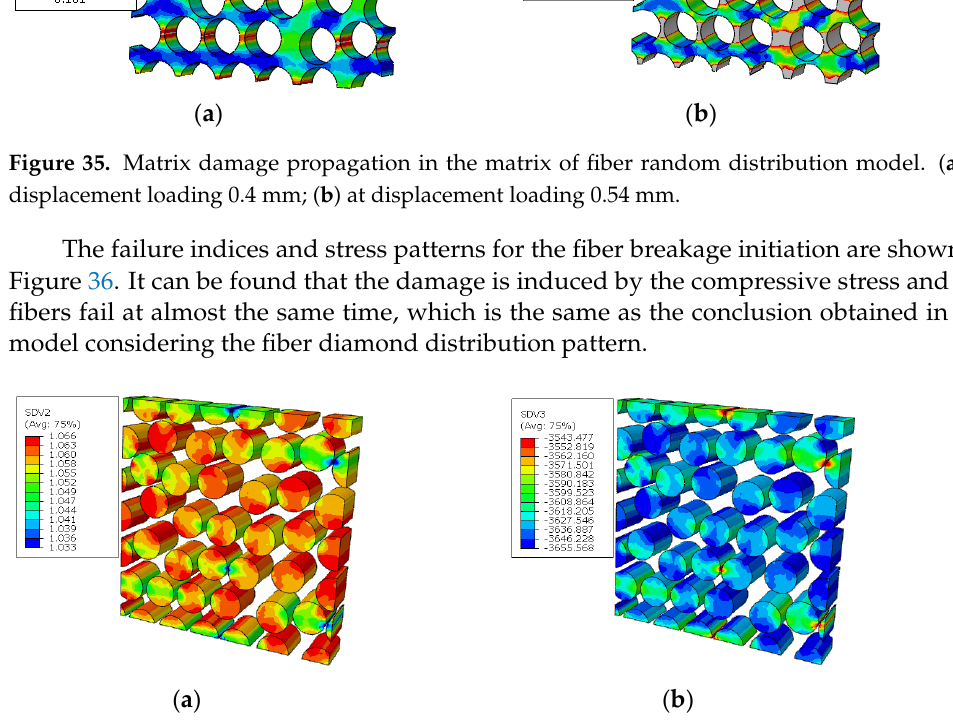
Figure 36. Failure indices and stress states for the fiber. ( a ) failure indices; ( b ) compressive stress in the fiber direction.